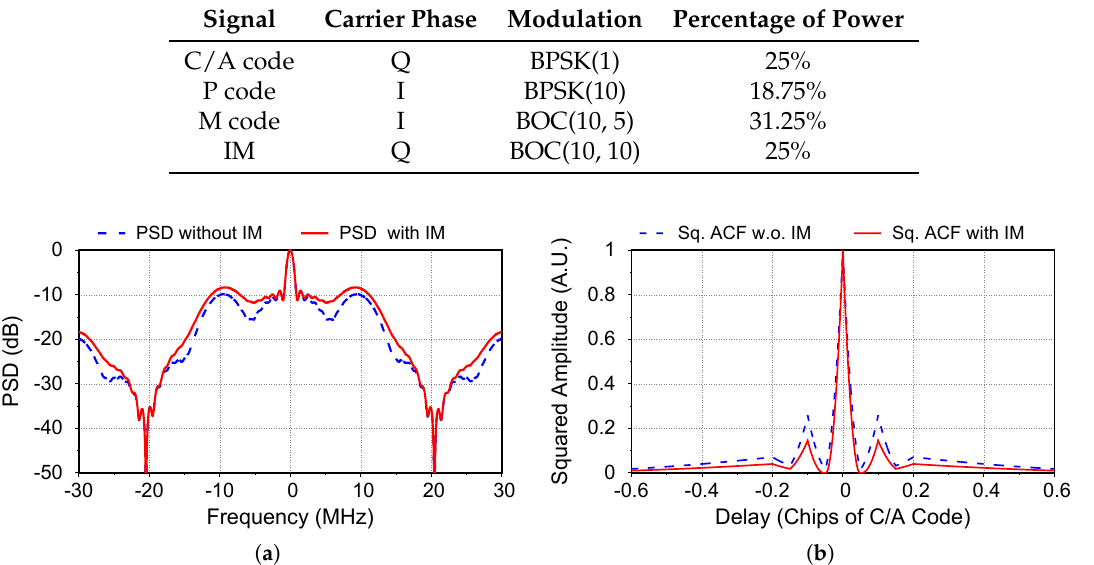
Table 1. Main characteristics of the signal components transmitted by GPS Block IIR-M satellites at L1 band computed from [22].